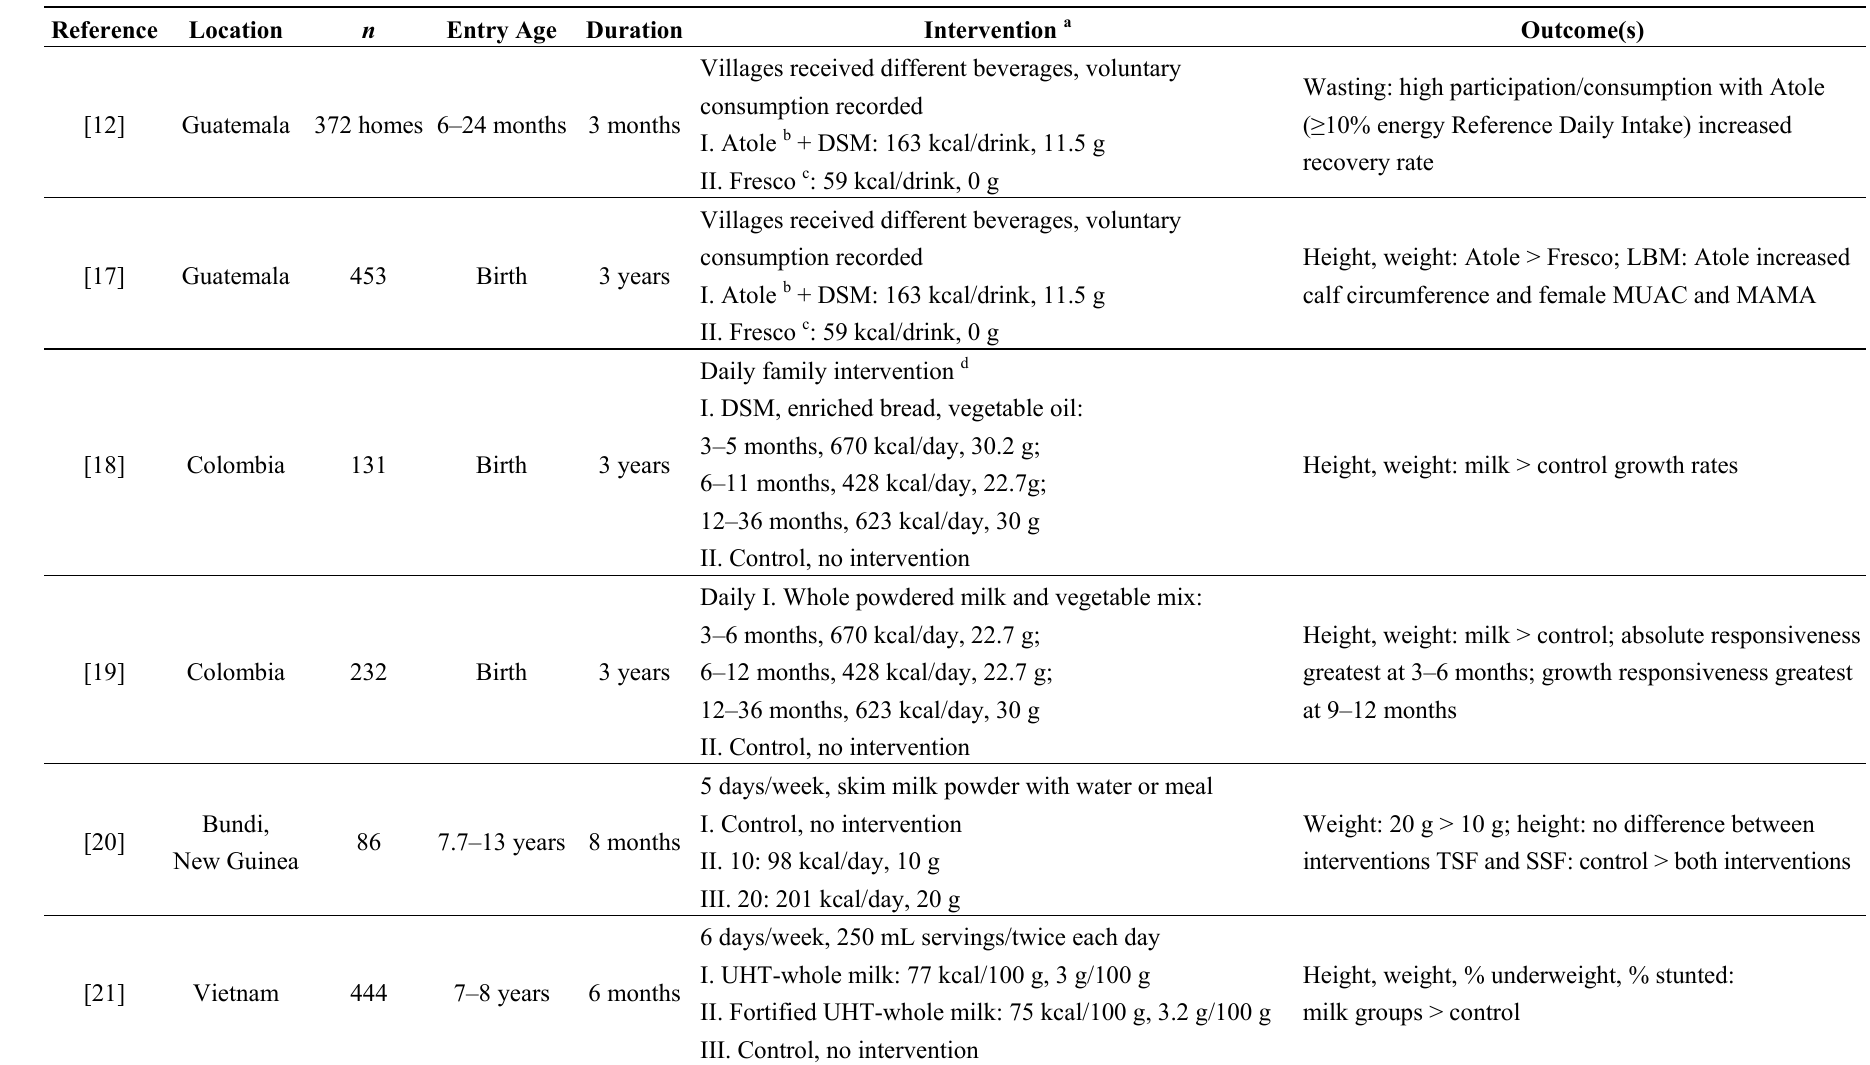
Table 2. Growth effects from animal source food (ASF) vs. no intervention or